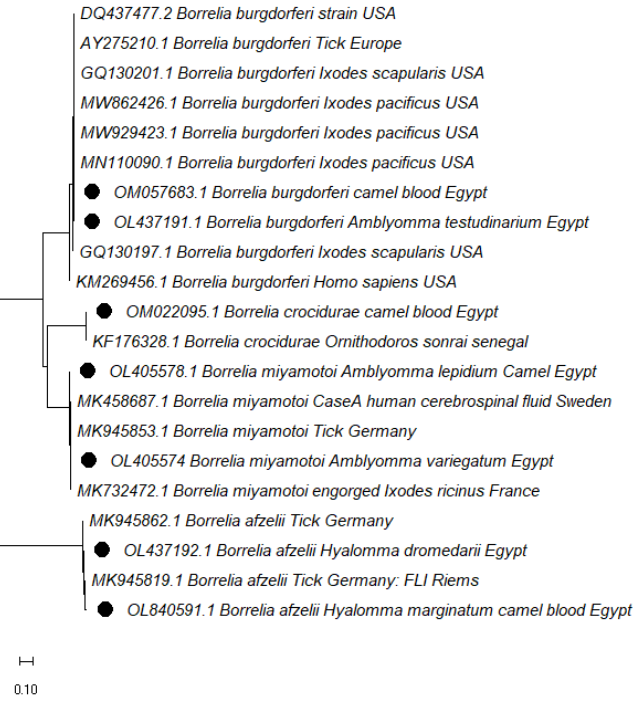
Figure 2. Phylogenetic analysis using Maximum Likelihood method. The evolutionary history of Borrelia spp. isolates, based on the 16S-23S IGS . The accession numbers with black dots are from this study.